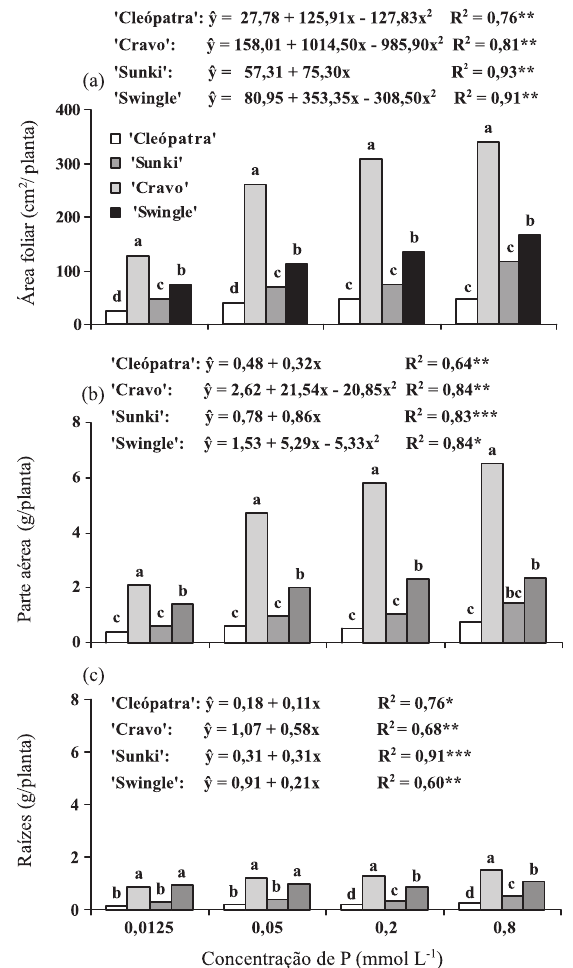
figura 1. Área foliar (a) e crescimento da